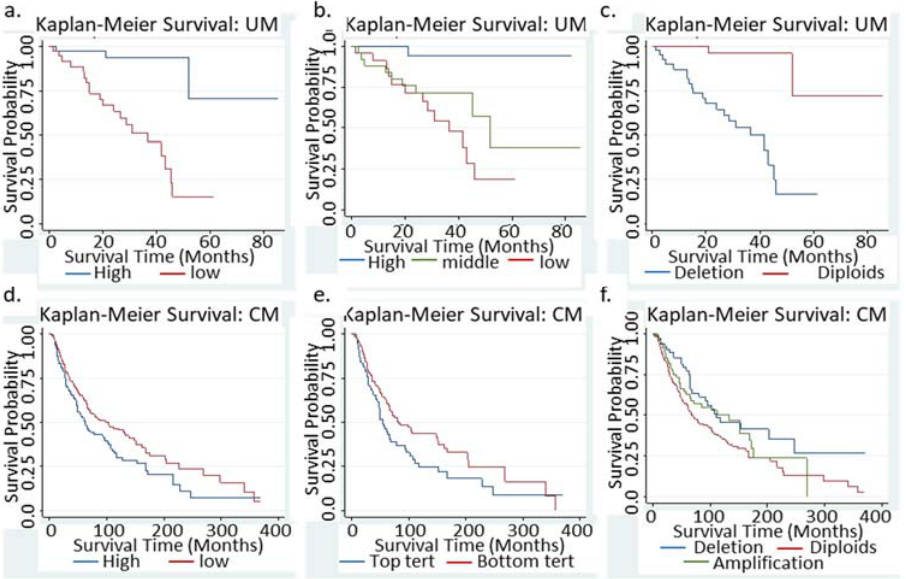
Figure 1. Kaplan–Meier survival curves in UM and CM. ( a , b ) Survival curves of patients with BAP1-low vs. BAP1-high tumors (mRNA level, bottom 50% vs. top 50% in ( a ), tertiles in ( b ). ( c ) Survival curves of UM patients with BAP1 copy number variation. ( d , e ) Survival curves of BAP1-low vs. BAP1-high tumors in CM patients. ( d ) BAP1-tumors with bottom 30% mRNA or with BAP1 mutations. These two categories contained all BAP1 hemizygous deletion tumors in UM. ( f ) survival curves of CM patients with various BAP1 copy number variations.